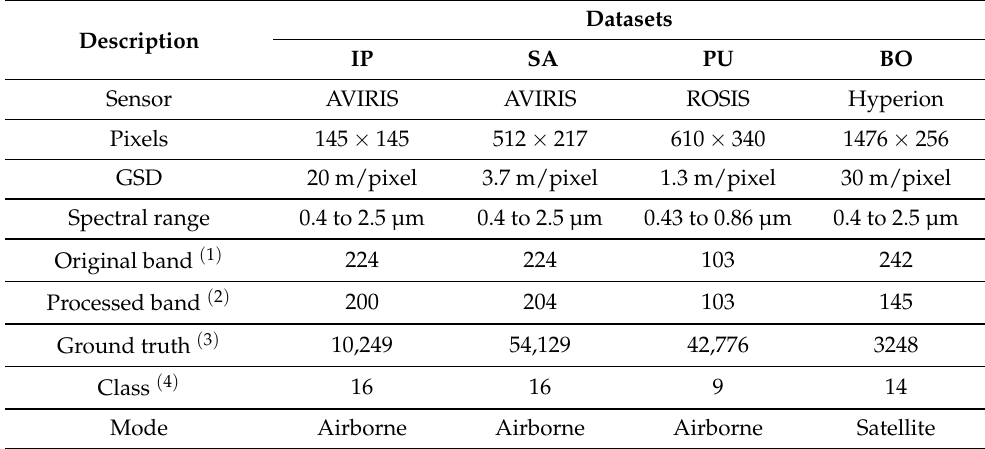
Table 1. Summary of the characteristics of the IP, SA, PU, and BO datasets.